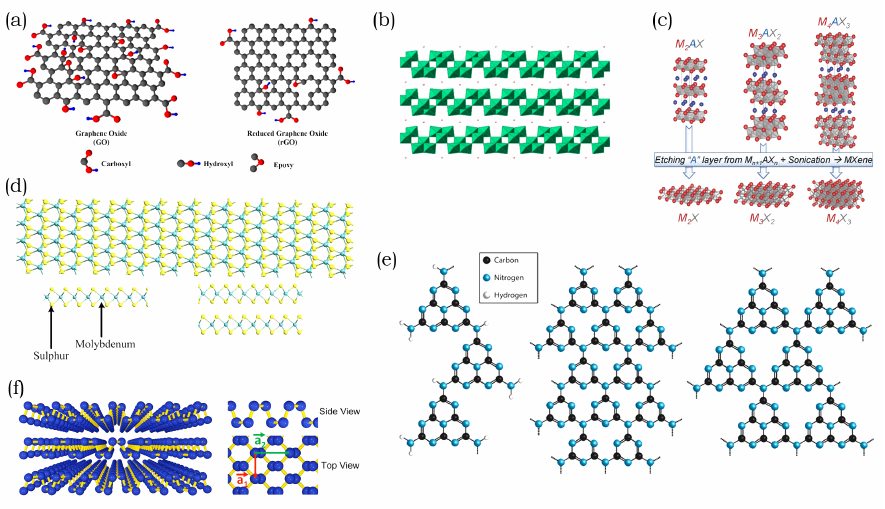
Figure 2. Molecular structures of different 2D nanomaterials. ( a ) GO and rGO nanosheets. Reproduced with permission from [47], published by MDPI AG. License CC-BY. ( b ) Layered structure of HNb 3 O